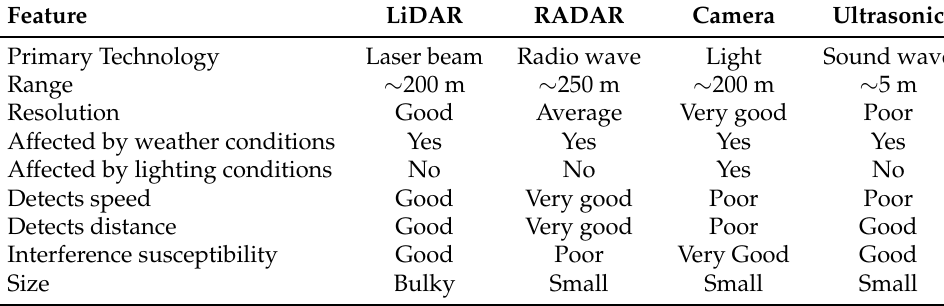
Table 1. Summary of autonomous vehicles’